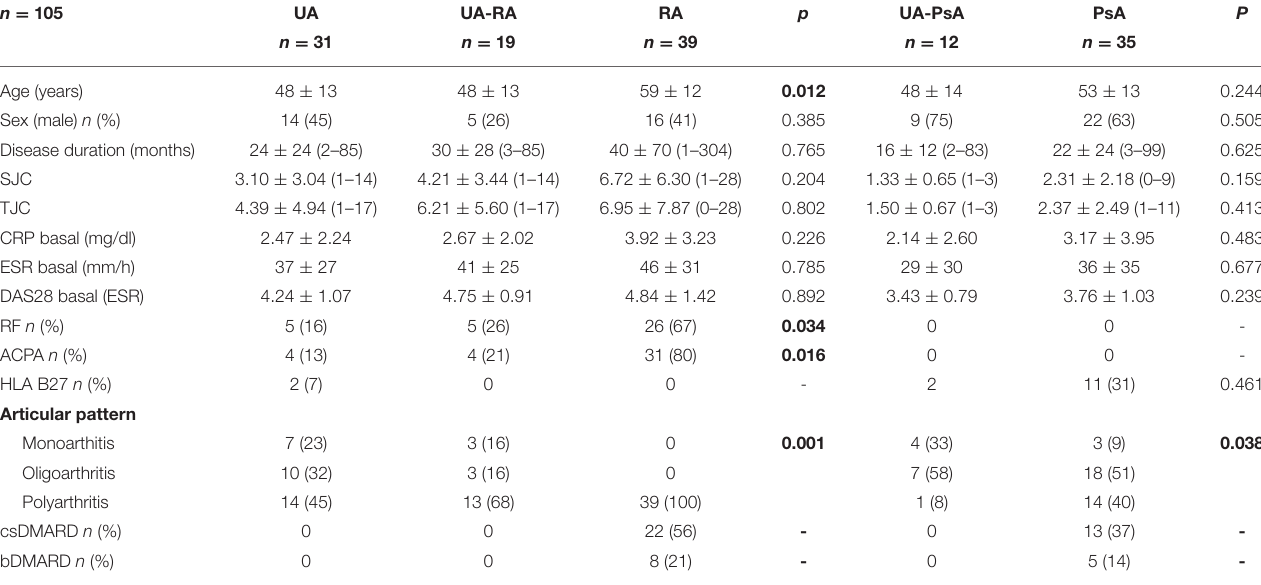
TABLE 1 | Demographic, clinical, and serological